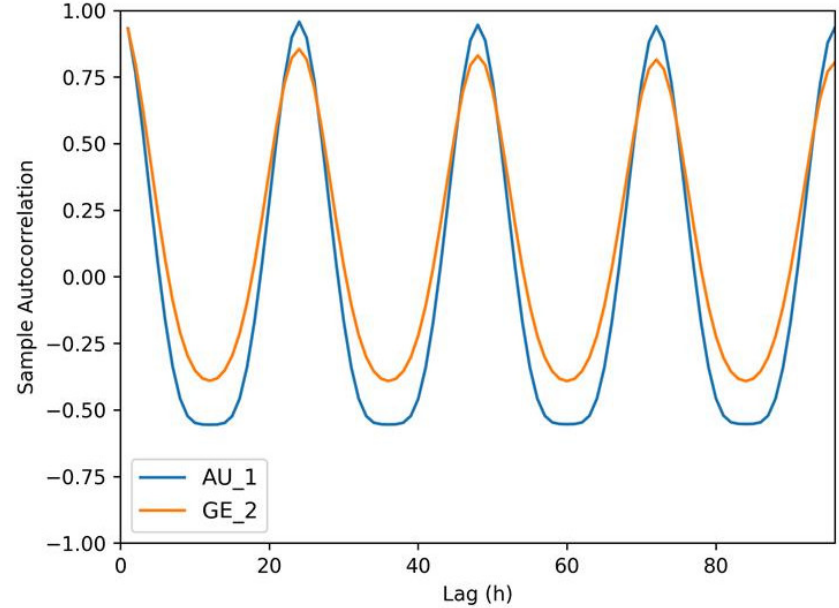
Figure 6. Autocorrelation function (ACF) of PV energy production time series data. Table 4. Pearson correlation coefficient (PCC) between target value (PV energy production) and the meteorological variables and solar angles.